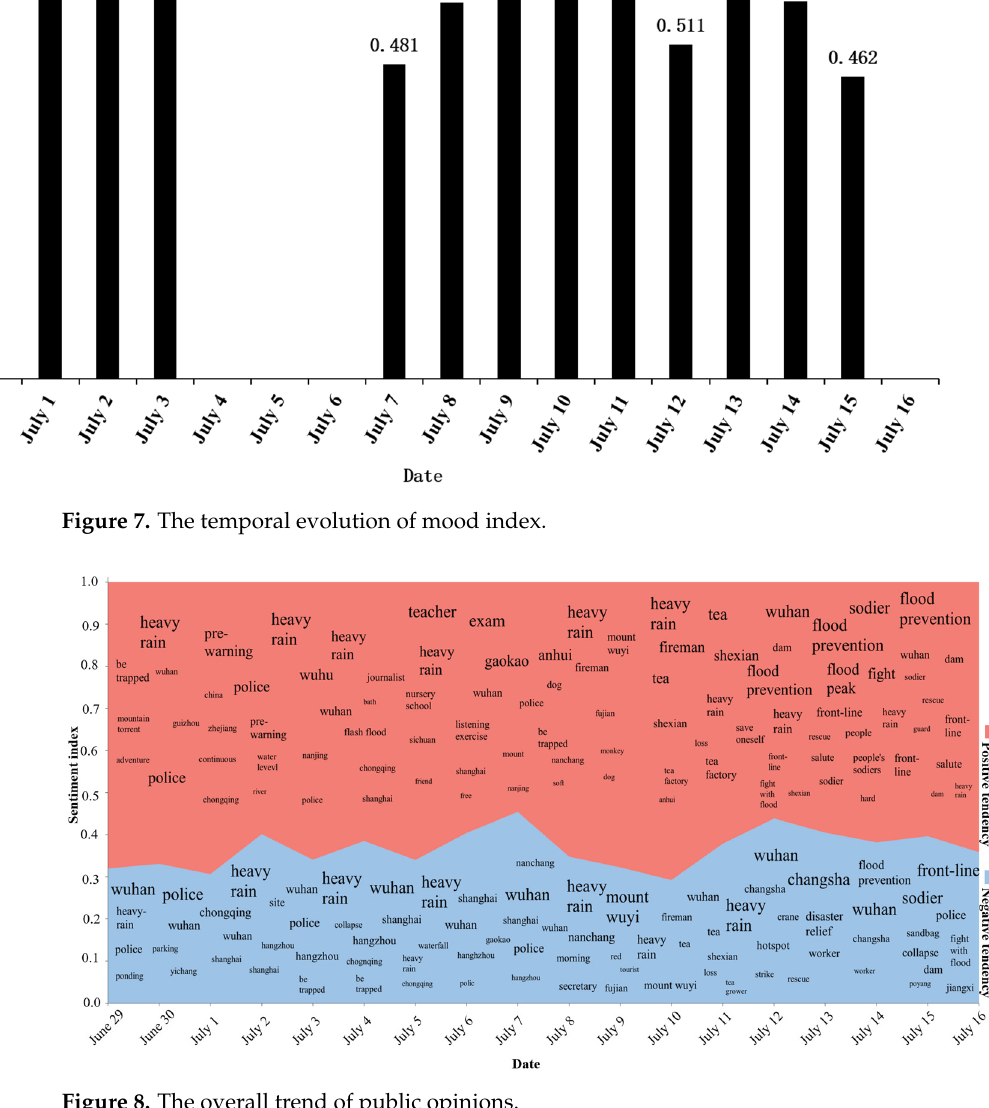
Figure 8. The overall trend of public opinions.